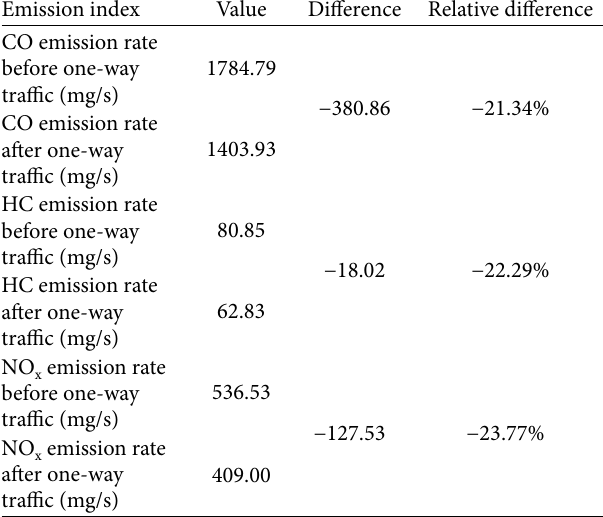
Table 8: Regional overall emissions before and after one-way